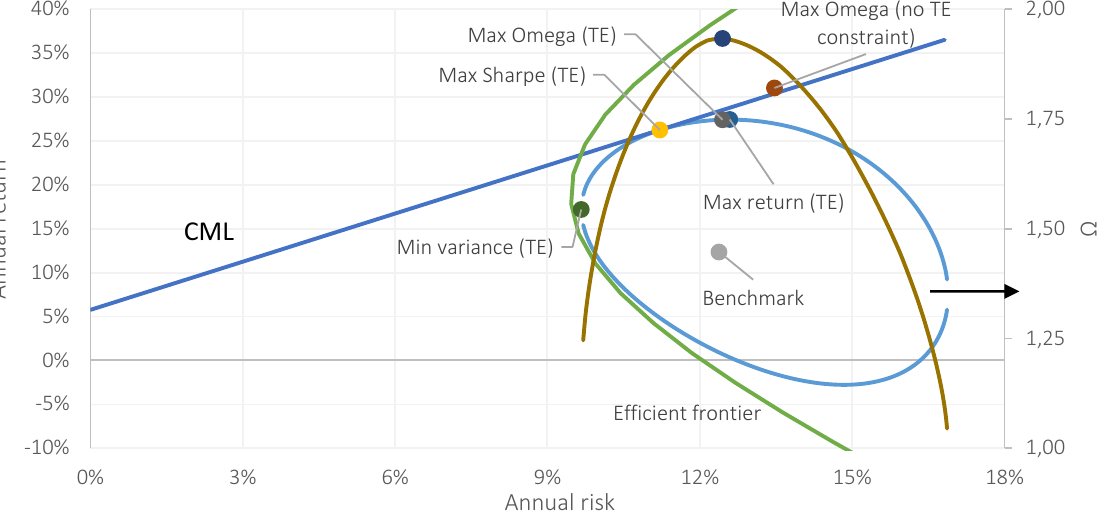
Figure 3. Orientation of relevant components in Oct-14. TE = 6% and r